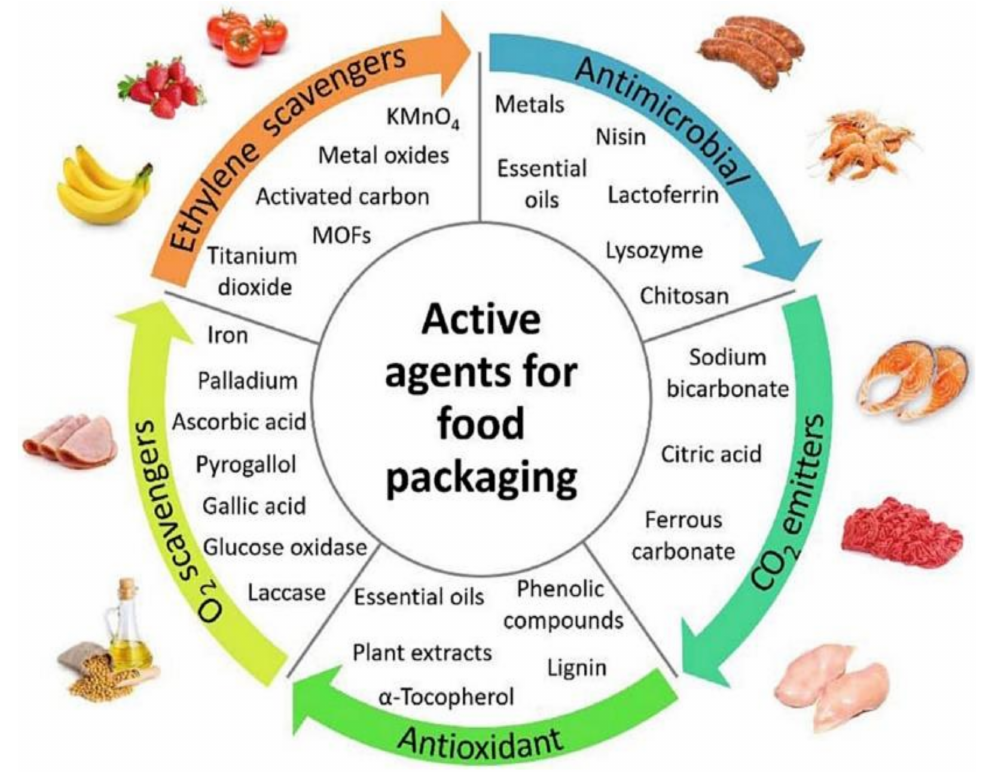
Figure 1. Active agents used in food packaging (Adopted from Vilela et al.